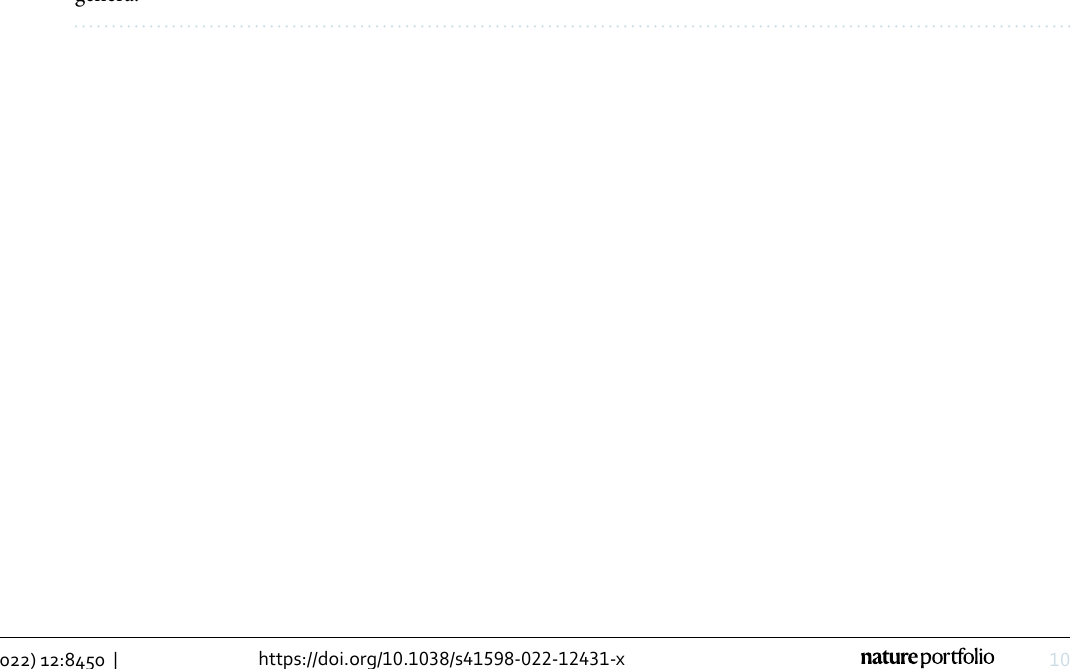
Figure 5. Color-coded Spearman correlation matrix of the relative abundance of gastric mucosa-associated